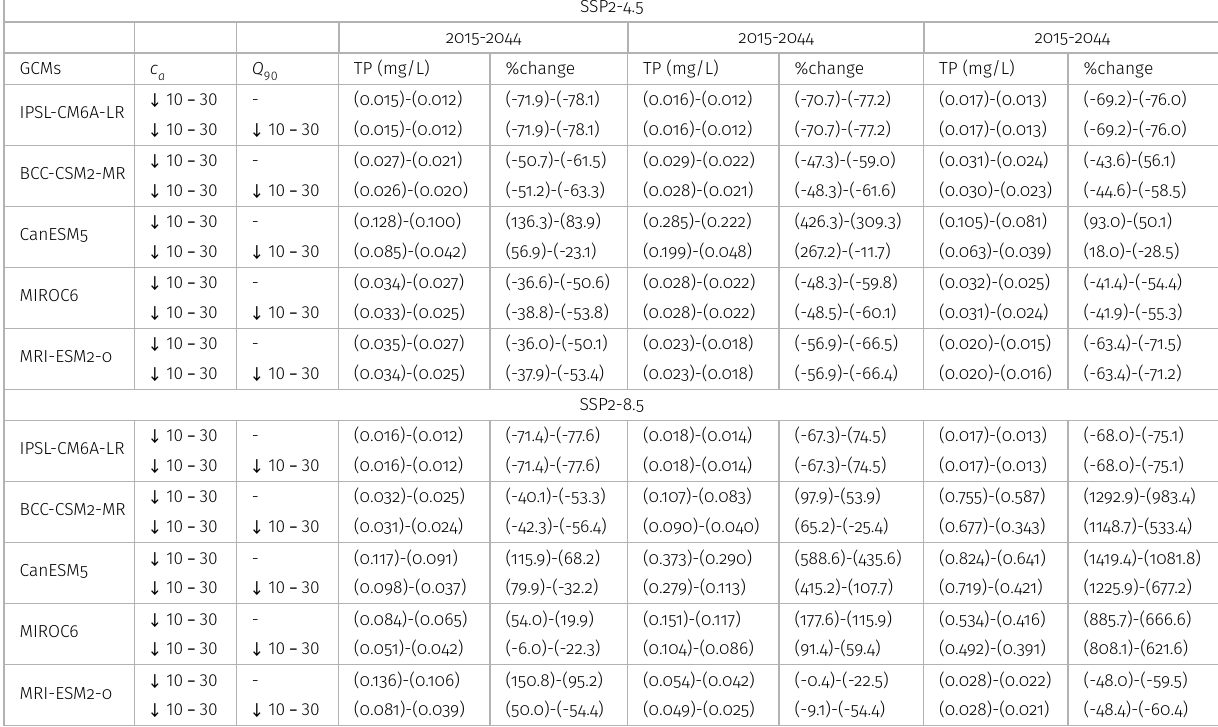
Table III. Simulations of reductions in the influent Phosphorus Total (TP) concentration and reservoir withdrawal. Note that realistic reductions of 10-30% were